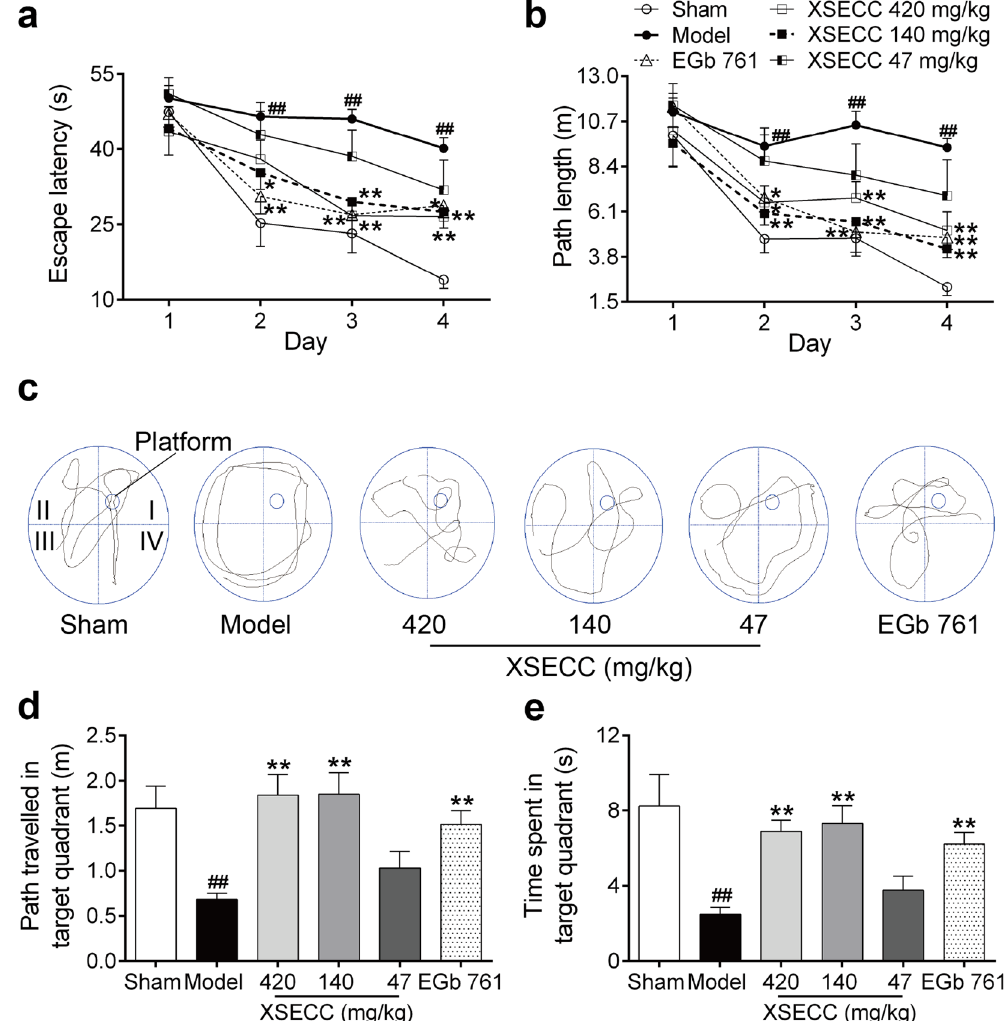
Figure 1. Effects of XSECC on Morris water maze performance deficits in BCCAO rats. ( a ) Escape latency and ( b ) path length of rats to find the emerged platform during the training trial (two-way ANOVA with repeated measures followed by Turkey’s post hoc tests). ( c ) Swimming traces of rats in the probe trial. The small cycle in quadrant I represents the platform and the big cycle represents the pool edge. ( d ) Path travelled and ( e ) time spent of rats in the target quadrant (quadrant I) during the probe test. ## P < 0.01 vs . sham group; * P < 0.05, ** P < 0.01 vs . model group (one-way ANOVA followed by LSD’s post hoc test, XSECC 47 mg/kg group, n =